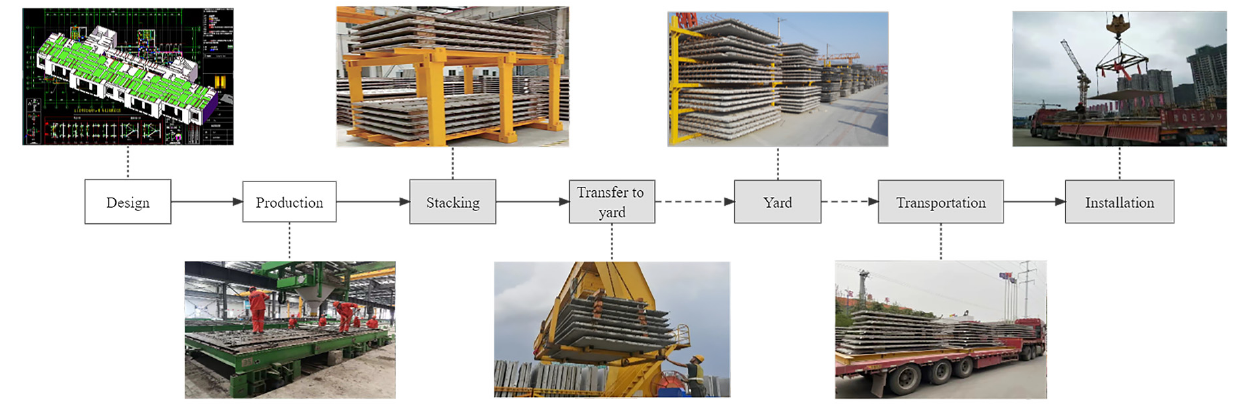
Figure 1. Processes of concrete slabs construction (logistical processes highlighted in gray).